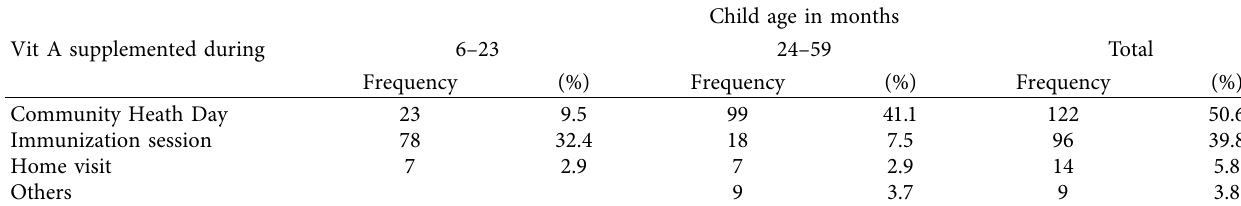
Table 5: Methods of VAS among children aged 6–59 months in Aleta Chuko woreda, SNNPR, 2019. Vit A supplemented during Community Heath Day